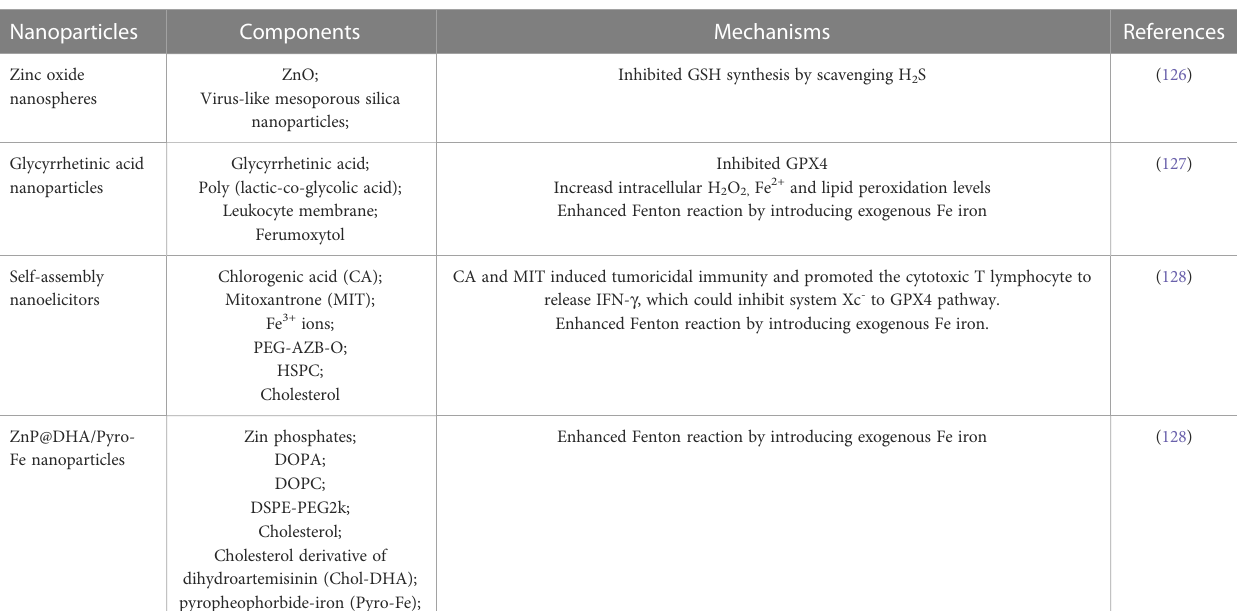
TABLE 2 Nanoparticles based on ferroptosis for CRC